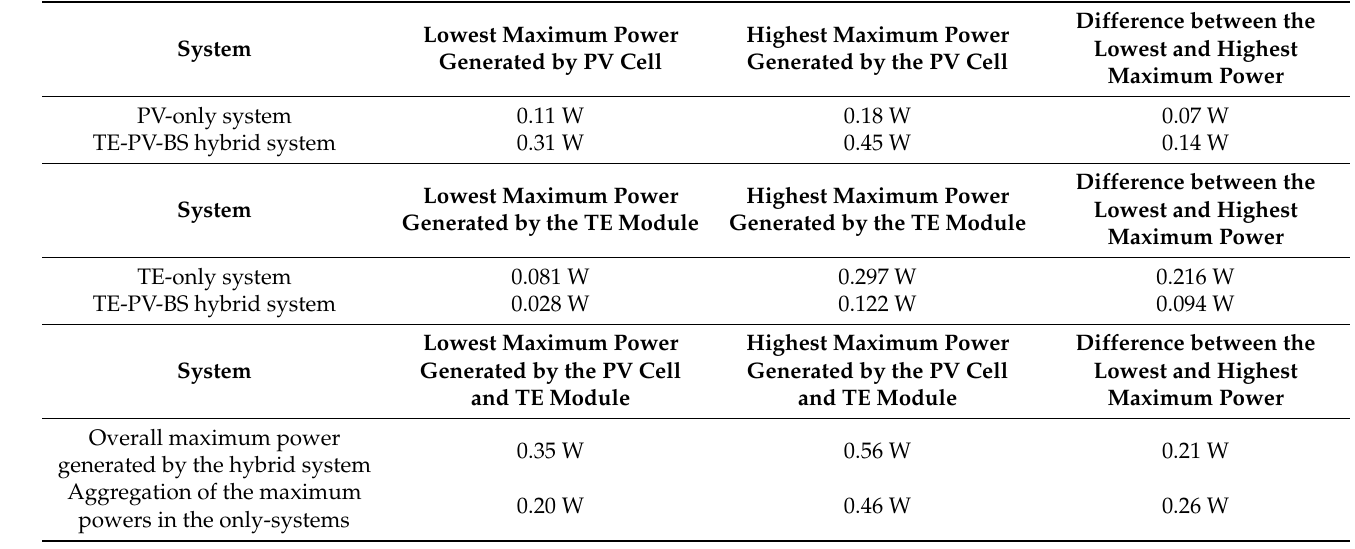
Table 1. Comparison of the maximum power generated by each system.